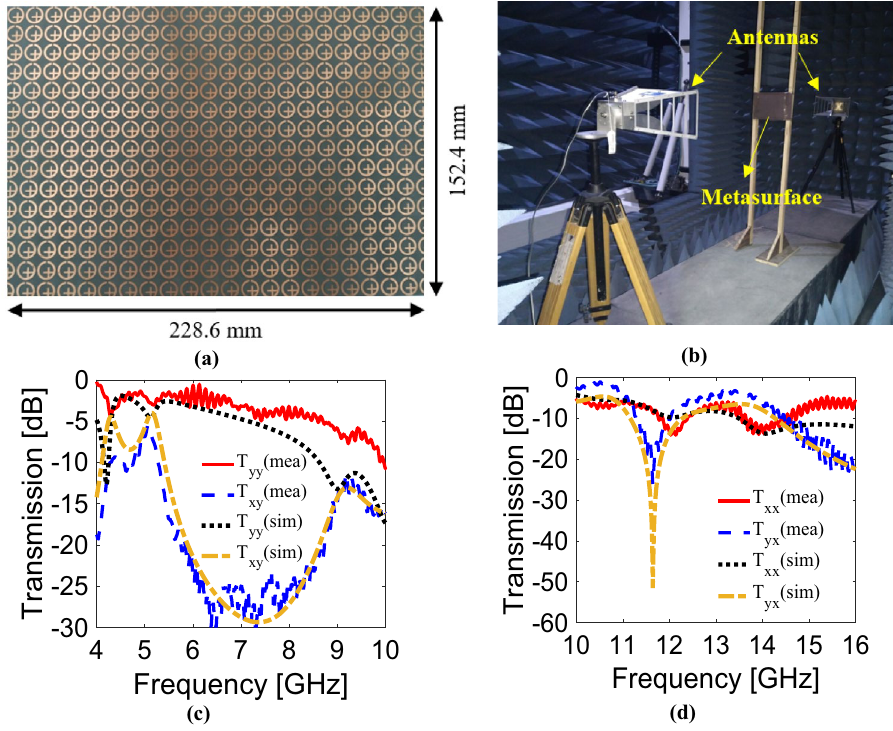
Figure 8. ( a ) Photograph of the fabricated metasurface, ( b ) experimental measurements setup, ( c ) comparison between simulated and measured results for TE wave, ( d ) comparison between simulated and measured results for TM